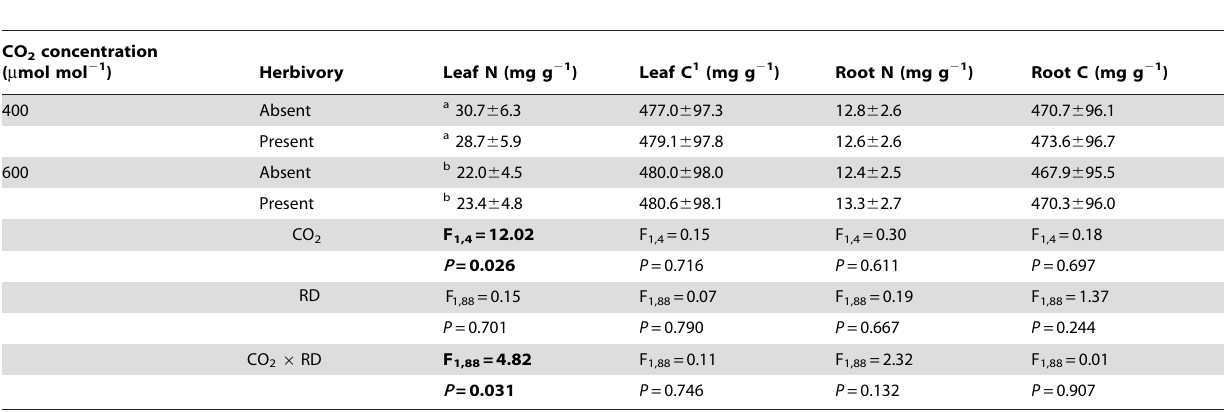
Table 2. Carbon and nitrogen concentrations of shoots and roots of plants grown at aCO 2 (400 m mol mol 2 1 ) and eCO 2 (600 m mol mol 2 1 ) with and without root damaging insects